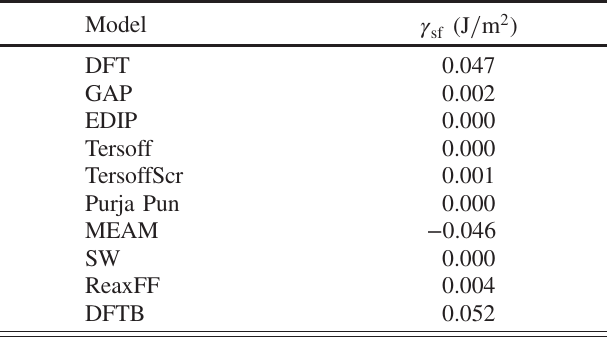
for each model. sf